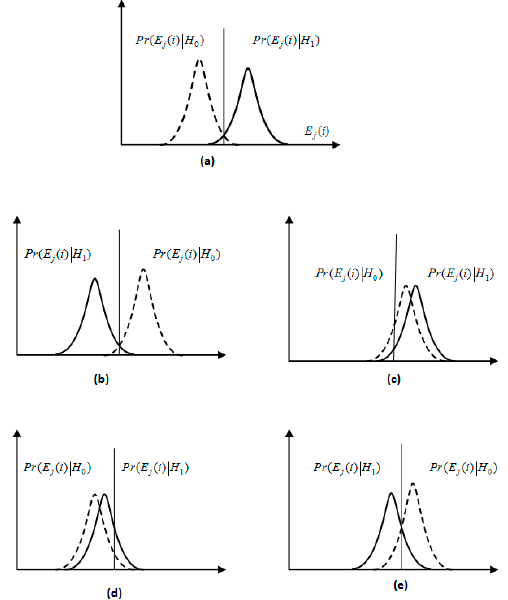
Figure 2. The PDF of the normal and malicious sensing reports: ( a ) Normal, ( b ) Always Opposite (AO) / Always Opposite Collusion (AOC), ( c ) Always Yes (AY) / Always Yes Collusion (AYC), ( d ) Always No (AN) / Always No Collusion (ANC) and ( e ) Random Opposite (RO) / Random Opposite Collusion